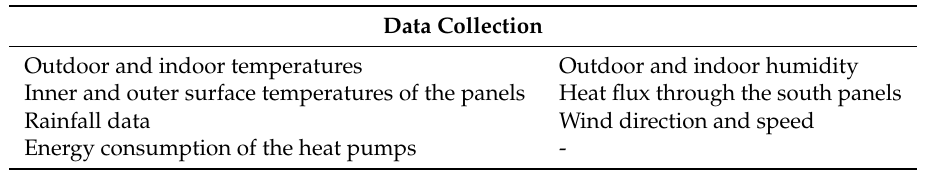
Table 1. Data collected from each cubicle.